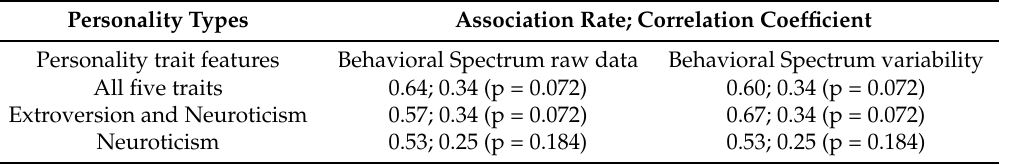
Table 3. Association between personality traits and user activity trials in AAL data.